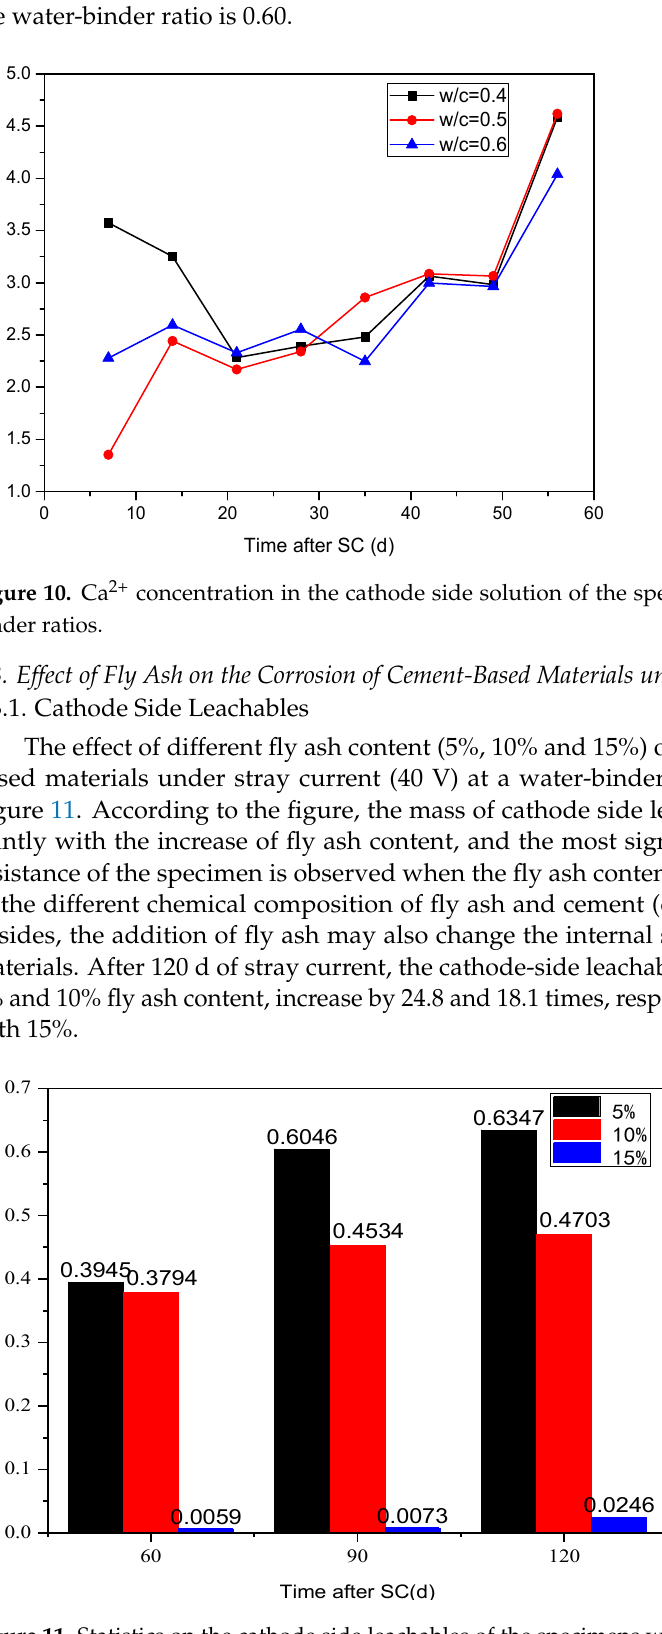
Figure 11. Statistics on the cathode side leachables of the specimens with different fly ash content.